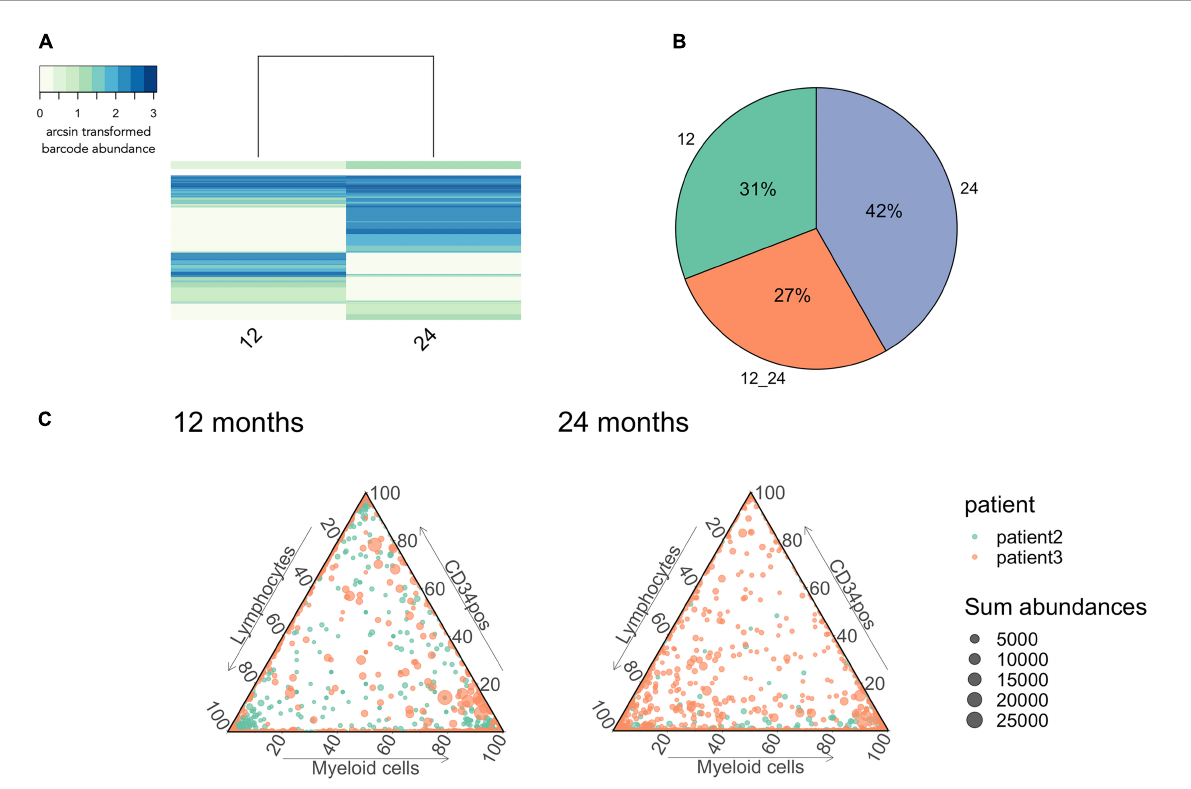
FIGURE9 Stabilization of multi-output HSPCs detected at 24 months after gene therapy. (A) IS sharing between 12 and 24 months. Heatmap done as in Figure 6 . (B) Percentage of barcodes shared between lymphocytes and myeloid cells at 24 months. (C) IS abundance in myeloid cells, lymphocytes and CD34positive cells. Each dot represents an IS, colored coded per patient while the size of each dot represents the total number of reads over the 3 lineages. n = 2 patients with patient 2 having in total 1,429 integration sites and patient 3